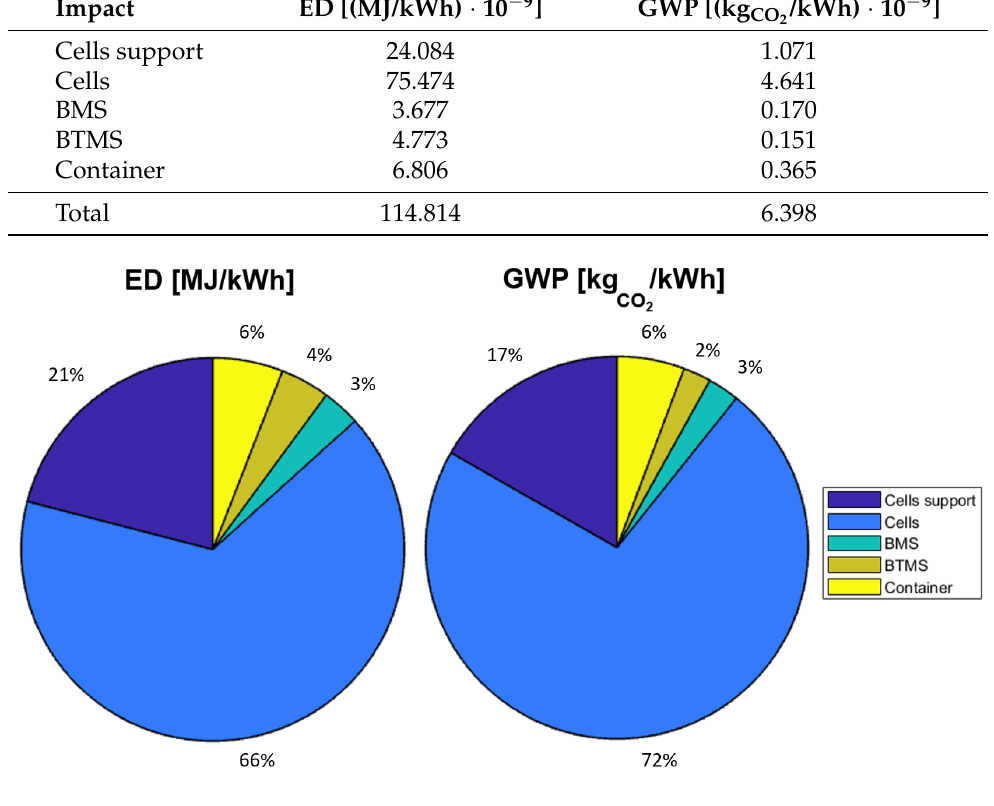
Figure 8. ED and GWP per unit of energy related to the entire LiBER battery